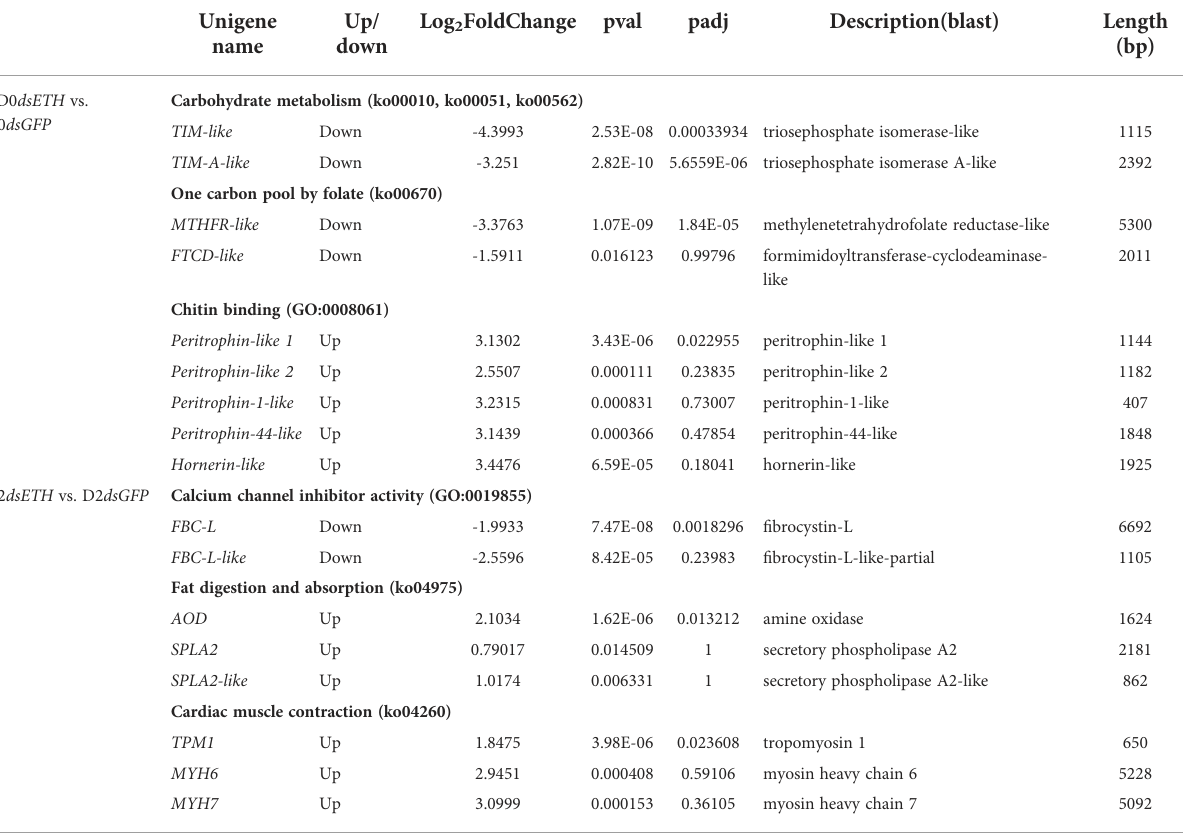
Table 2 DEGs related to metabolism and molting process from S. paramamosain responding to dsETH treatment at different premolt